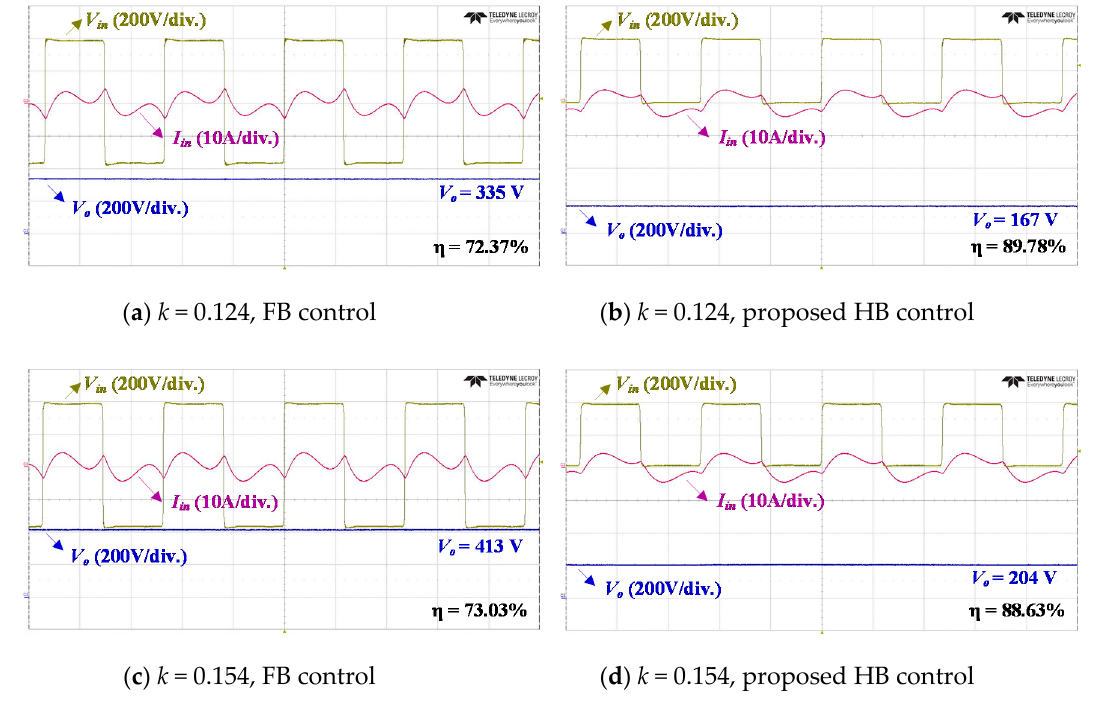
Figure 8. Experimental waveforms of the conventional FB control and the proposed control at P batt = 400 W.